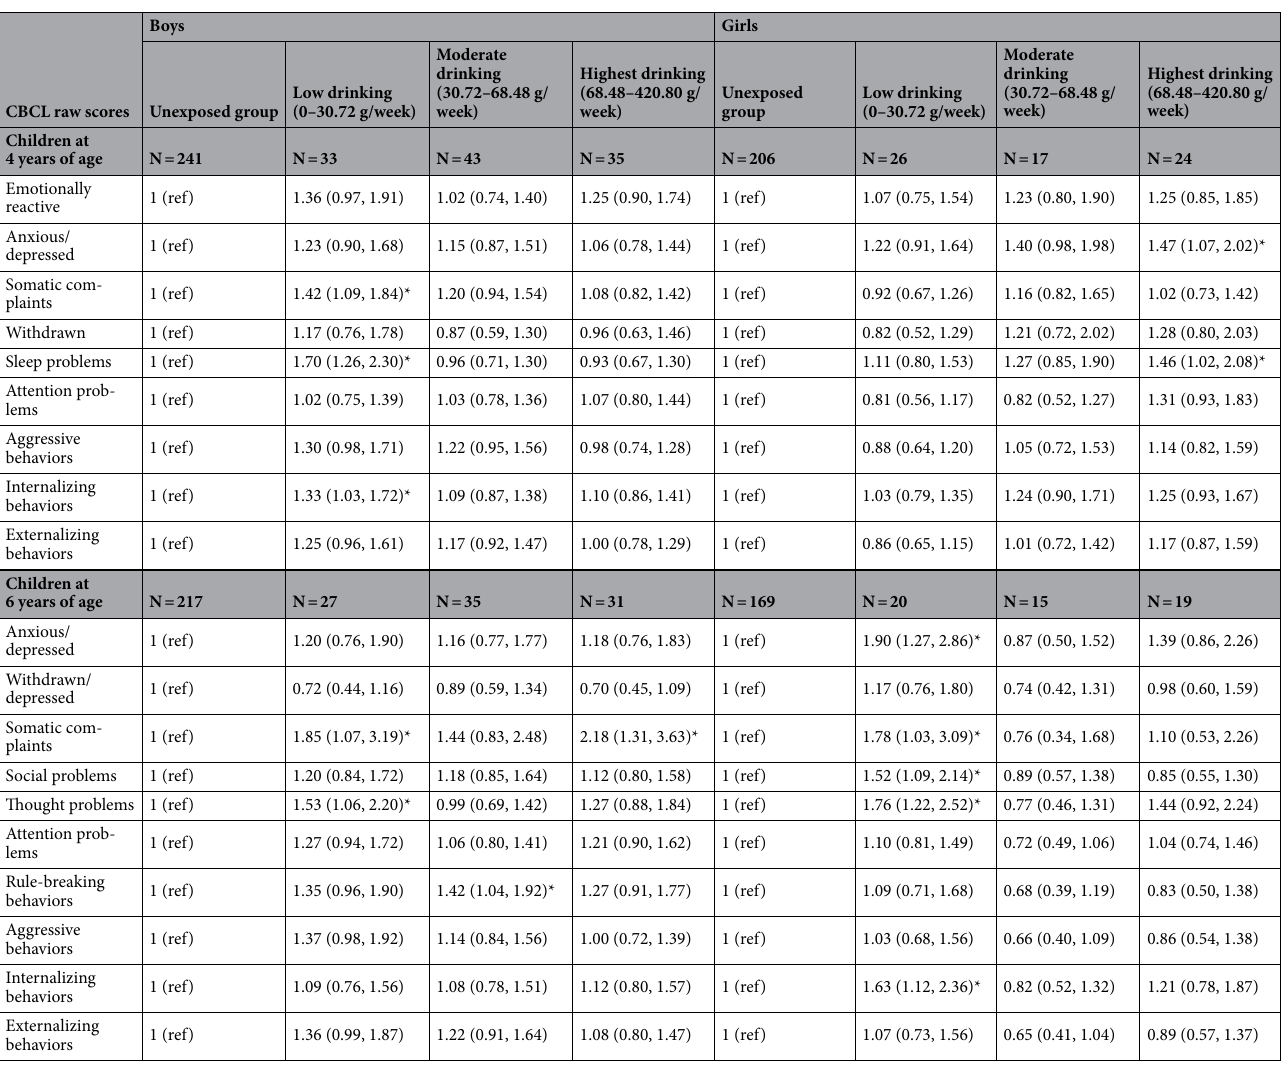
Table 3. Associations between preconceptional paternal alcohol consumption (cumulative consumption per week) and CBCL raw scores for children at 4 and 6 years of age . Adjusted for paternal age, paternal body mass index, paternal education, paternal smoking, maternal age, parity, maternal depressive symptoms during pregnancy, maternal preconception folic acid supplements, multivitamin supplements during pregnancy, and gestational weeks. CBCL Child Behavior Checklist. *Statistically significant differences ( P -value <